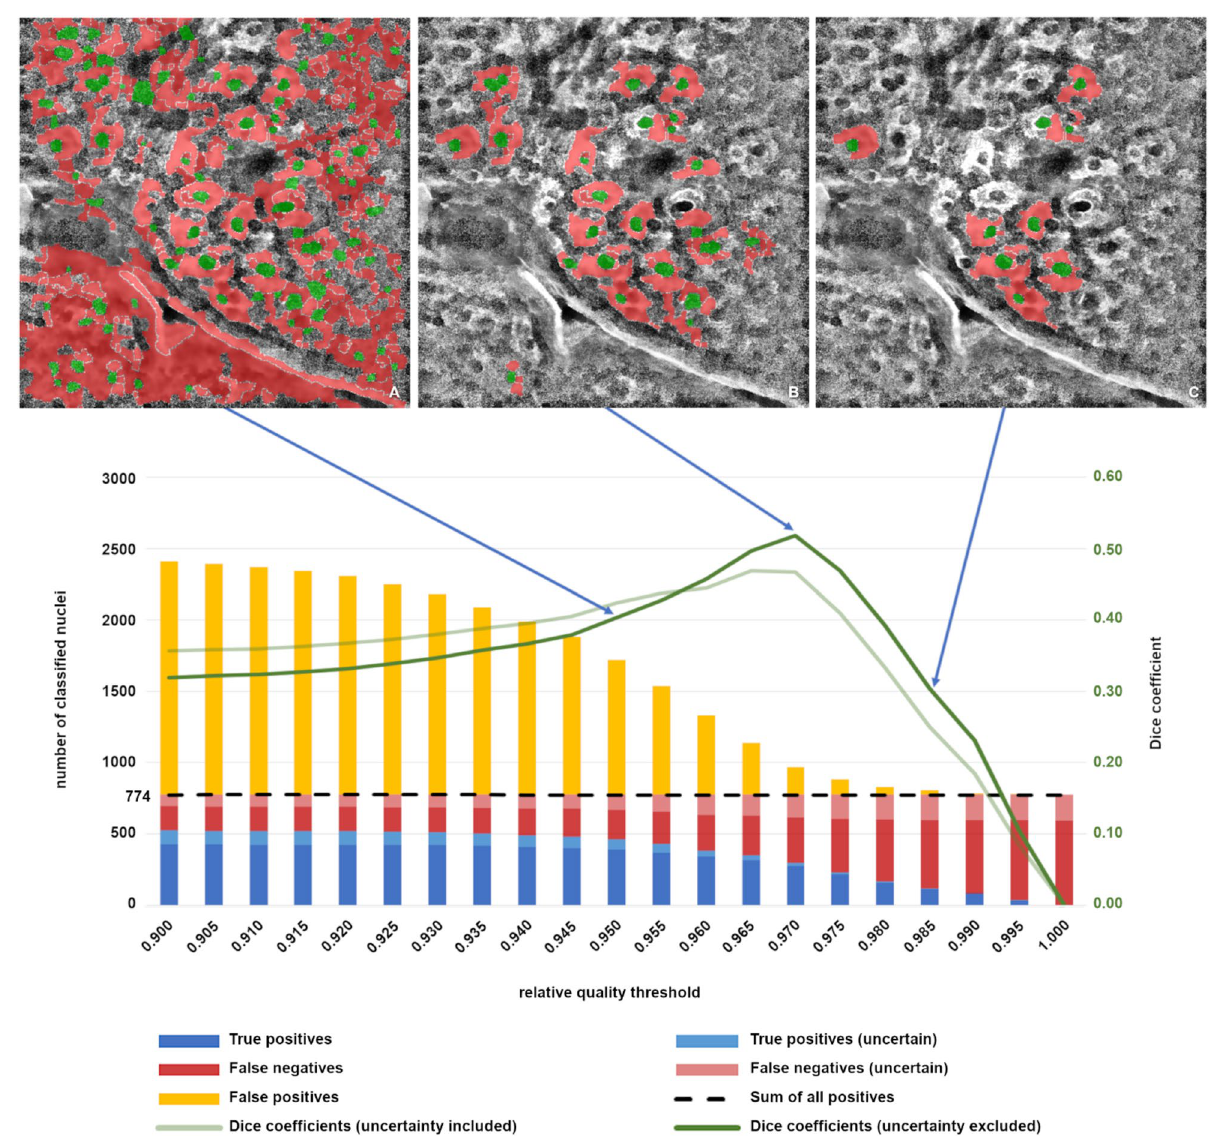
positives and misclassifications (left ordinate) for Slices 29–40, 45, 50, and Dice coefficient (right ordinate) with maximum at threshold 0.97 using different relative quality thresholds (abscissa). The number of total nuclei from ground truth is 774 (including certain and uncertain